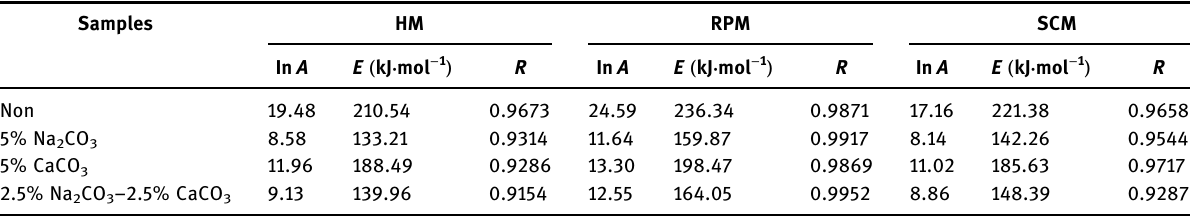
Table 5: Dynamic parameters corresponding to the three models